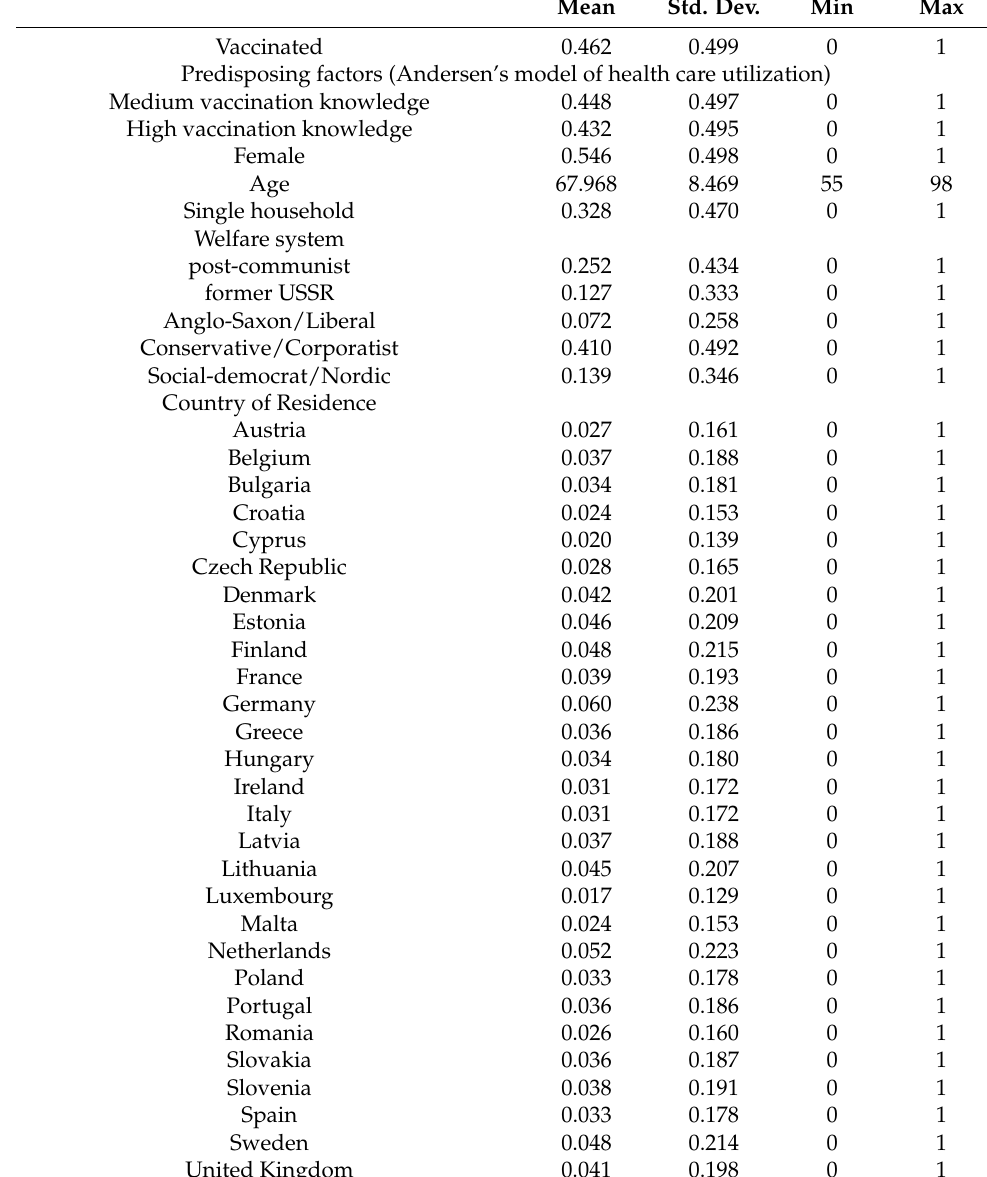
Table 2. Descriptive